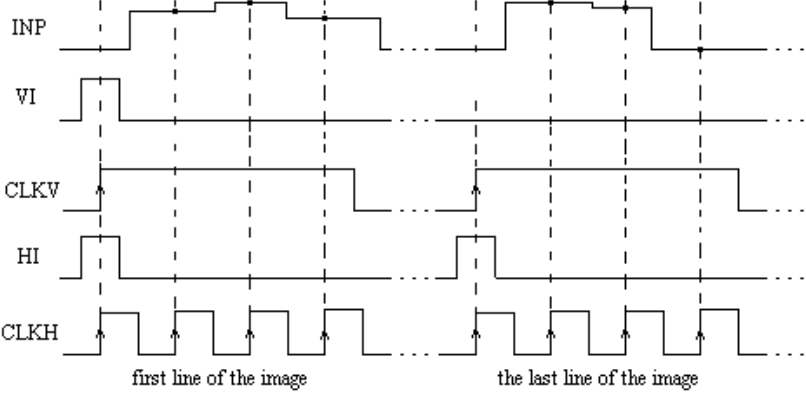
Figure 11. Control signals required for input image loading into a chip with oscillators frequency